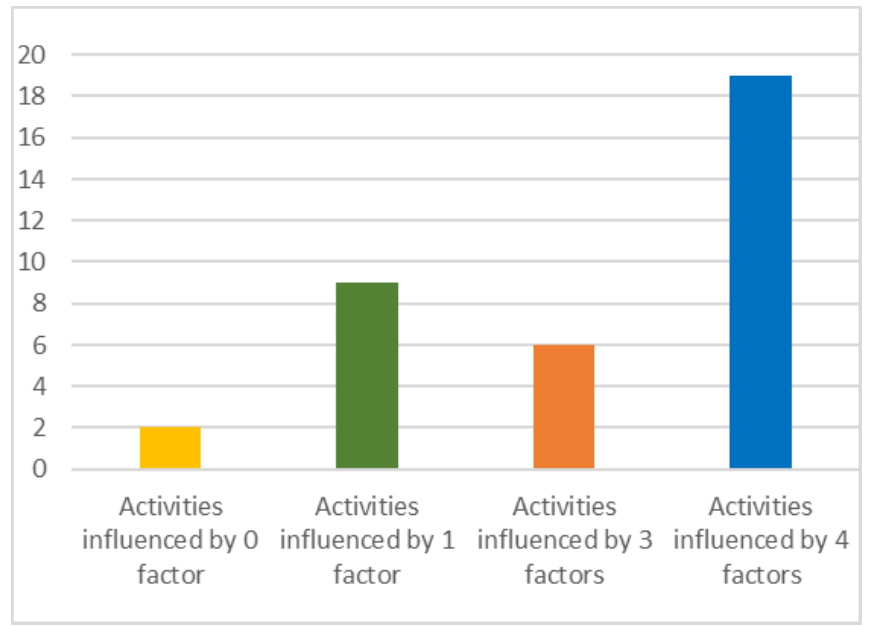
Figure 3 – The influence of factors versus